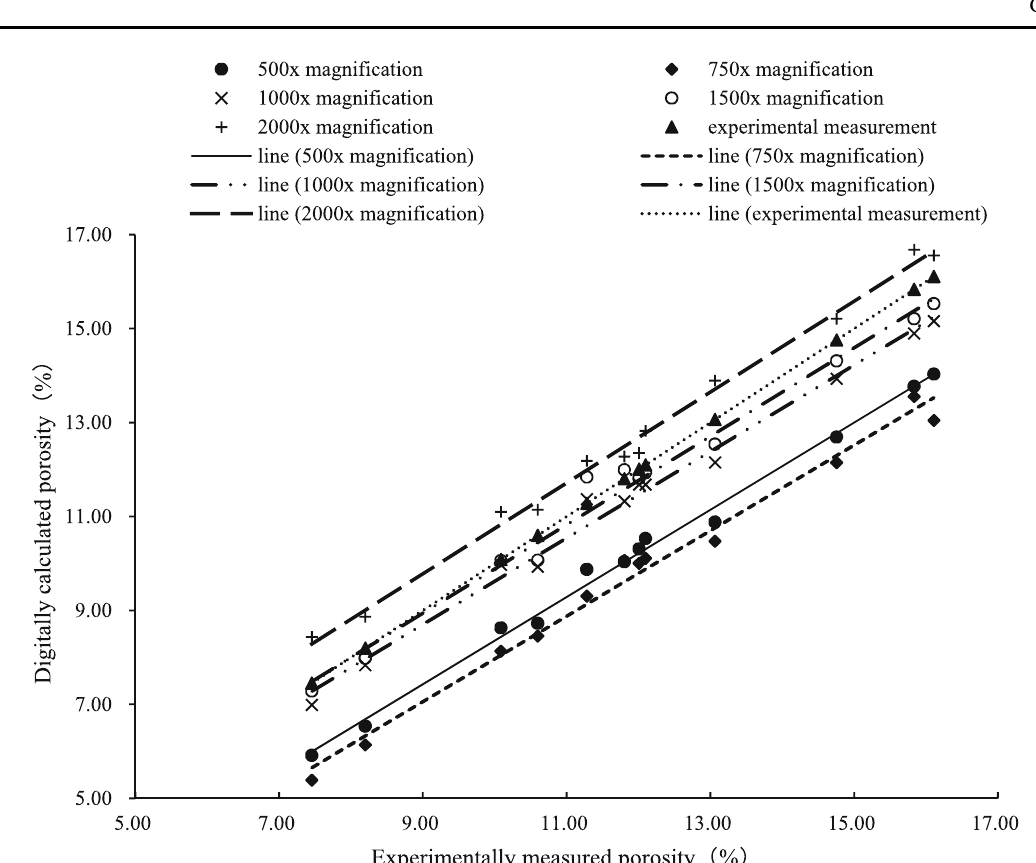
Fig. 8 Comparison of porosity calculated from digital images at different magnifications with experimental